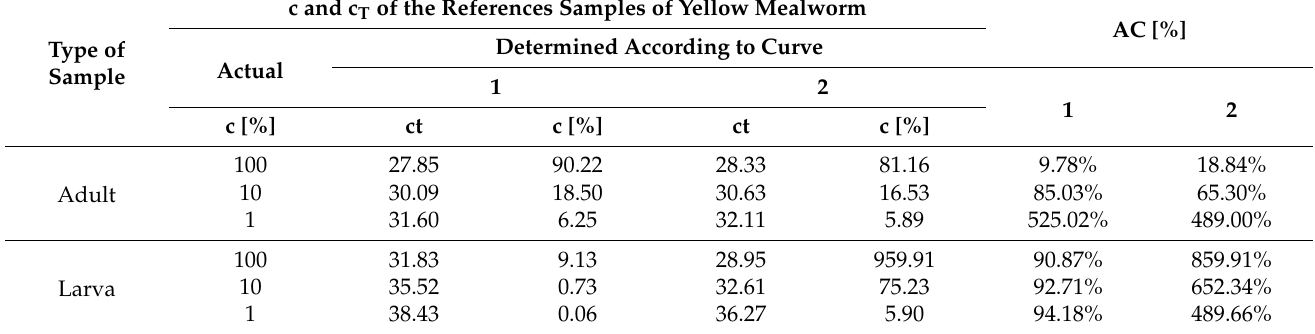
Table 8. Quantitative analysis of reference samples.